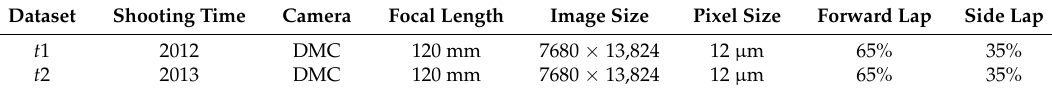
Table 2. Overview of the datasets used.